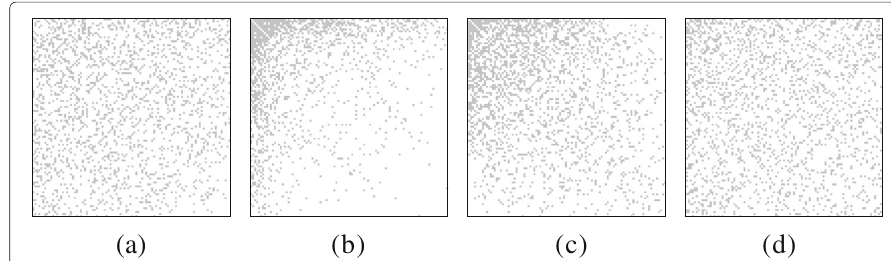
DC-SBM c R-MAT d